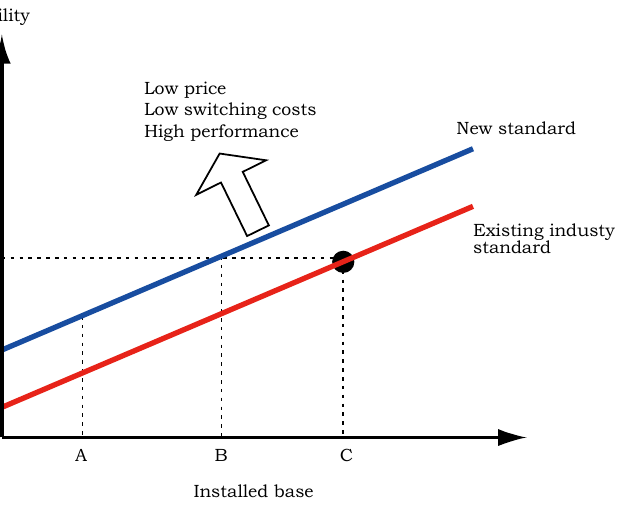
Figure 1. Generational shift of industry